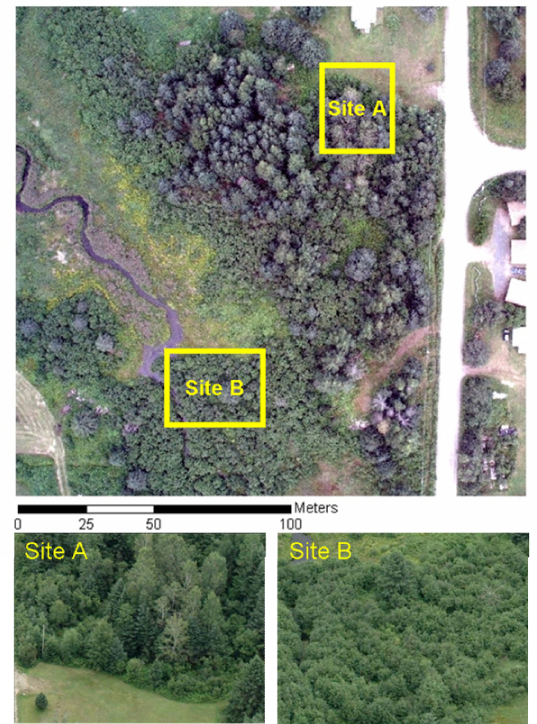
Figure 1: The true color composite imagery of the test area. Sites A and B were used to evaluate the generated DEM.